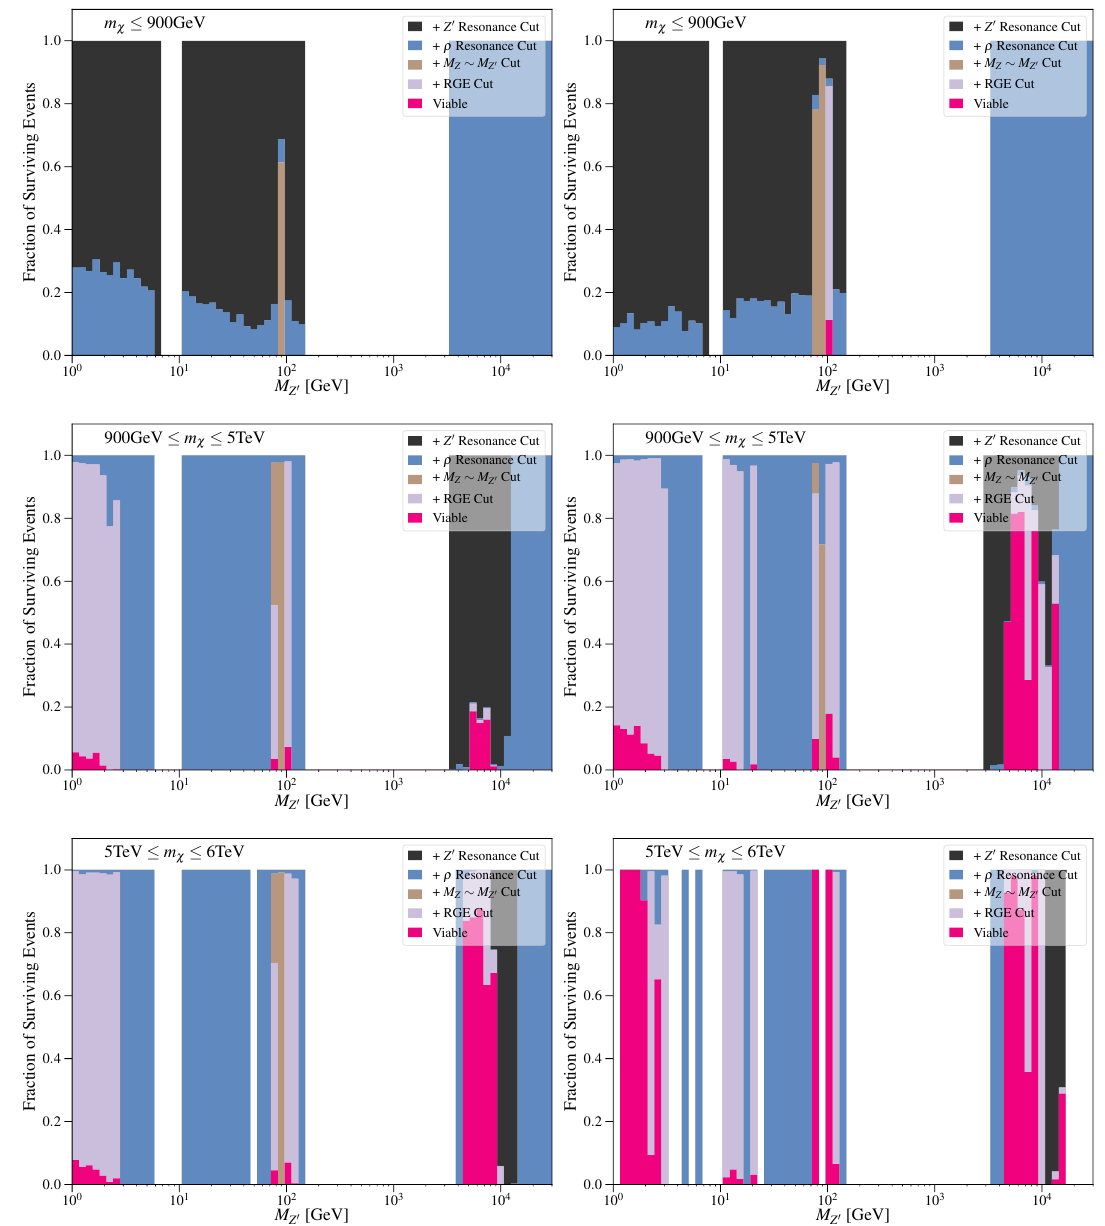
Figure 6 . Histograms showing the fraction of sampled points removed by each of the cuts described in section 5 for m (cid:31) < 900 GeV (top), 900 GeV < m (cid:31) < 5 TeV (middle), and 5 TeV < m (cid:31) < 6 TeV (bottom) as a function of m Z 0 . Left (right) panels denote the results for the full (reduced) bound analysis. Viable points surviving all cuts are shown in pink. When no histogram is shown (e.g. 150 GeV < m (cid:31) < 3 TeV) it is understood that no points in the sampling routine were capable of producing a viable dark matter candidate. Numerical values detailed the percentage of points surviving each cut are shown in table